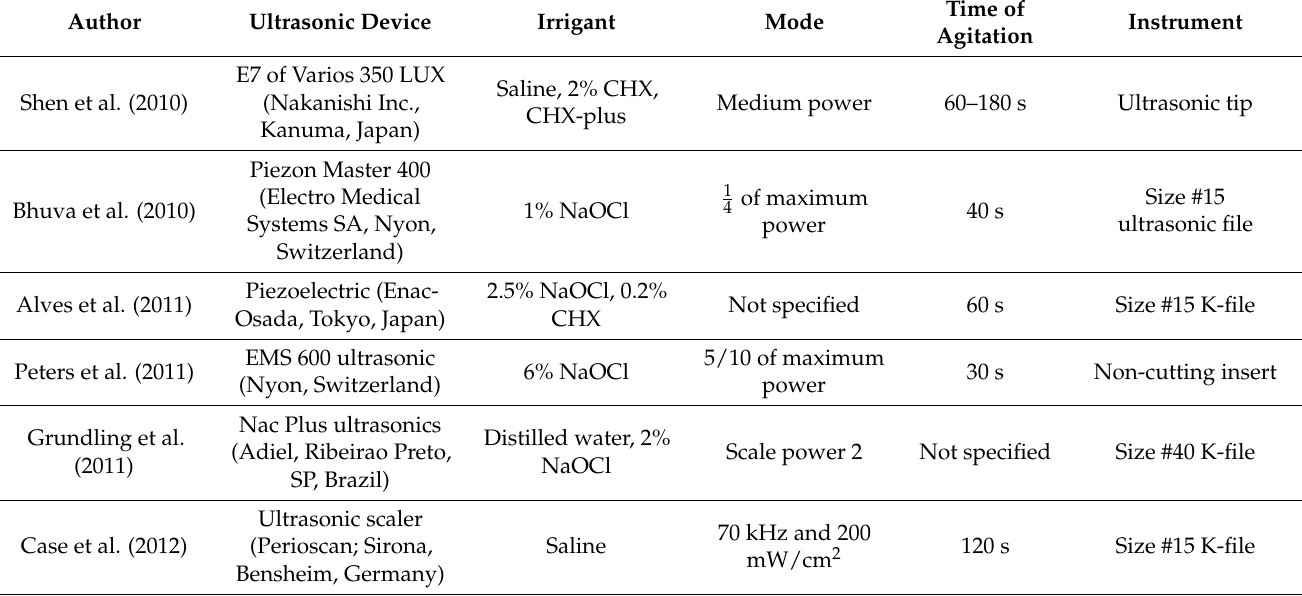
Table 3. Details on type of ultrasonic devices and instruments (manufacturers), irrigant, mode and time of agitation used in the studies included in the